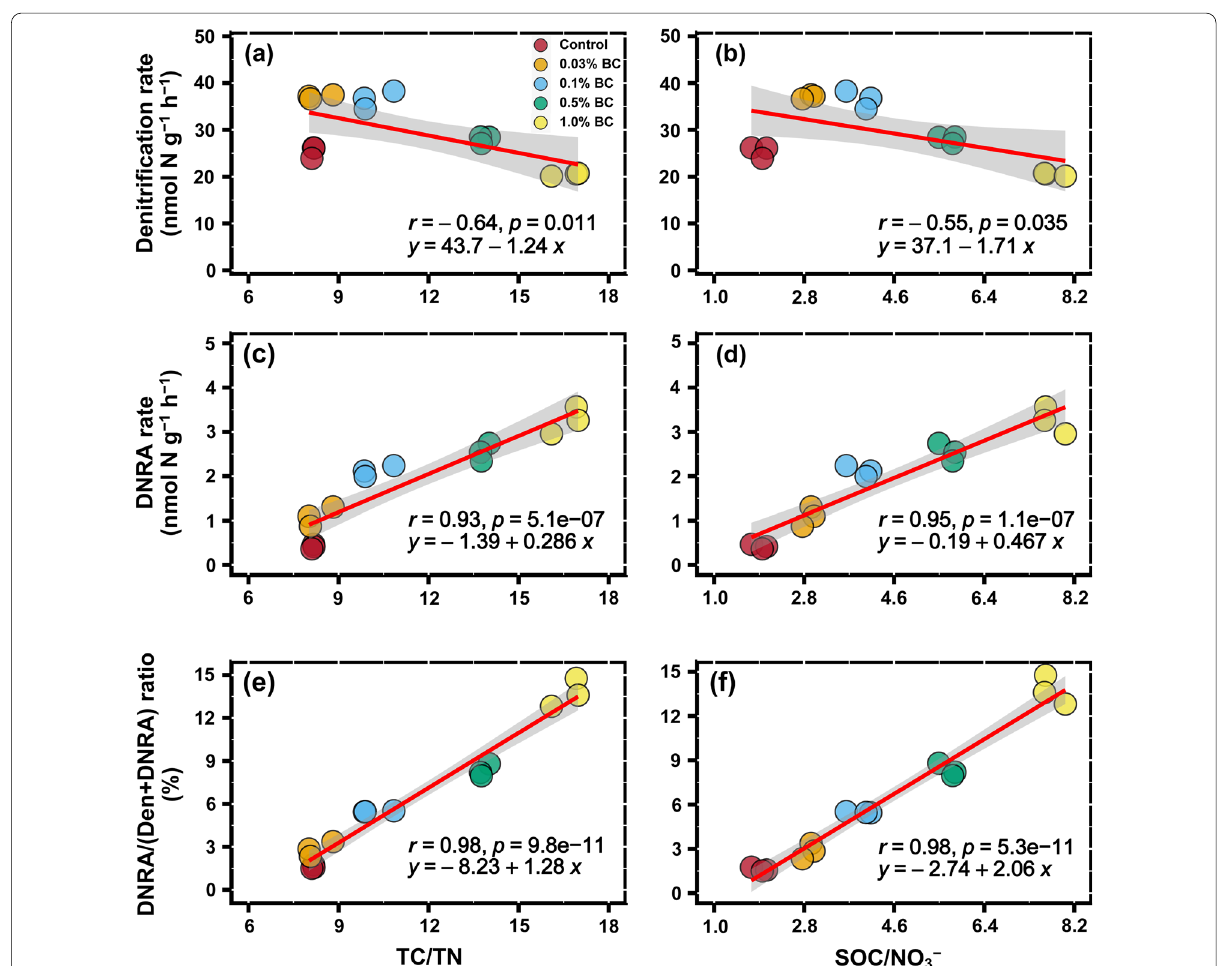
Fig. 6 Relationship of denitrification rates ( a , b ), DNRA rates ( c , d ), and DNRA/(Den biochar-amended treatments (Control, 0.03%BC, 0.1%BC, 0.5%BC, and 1.0%BC